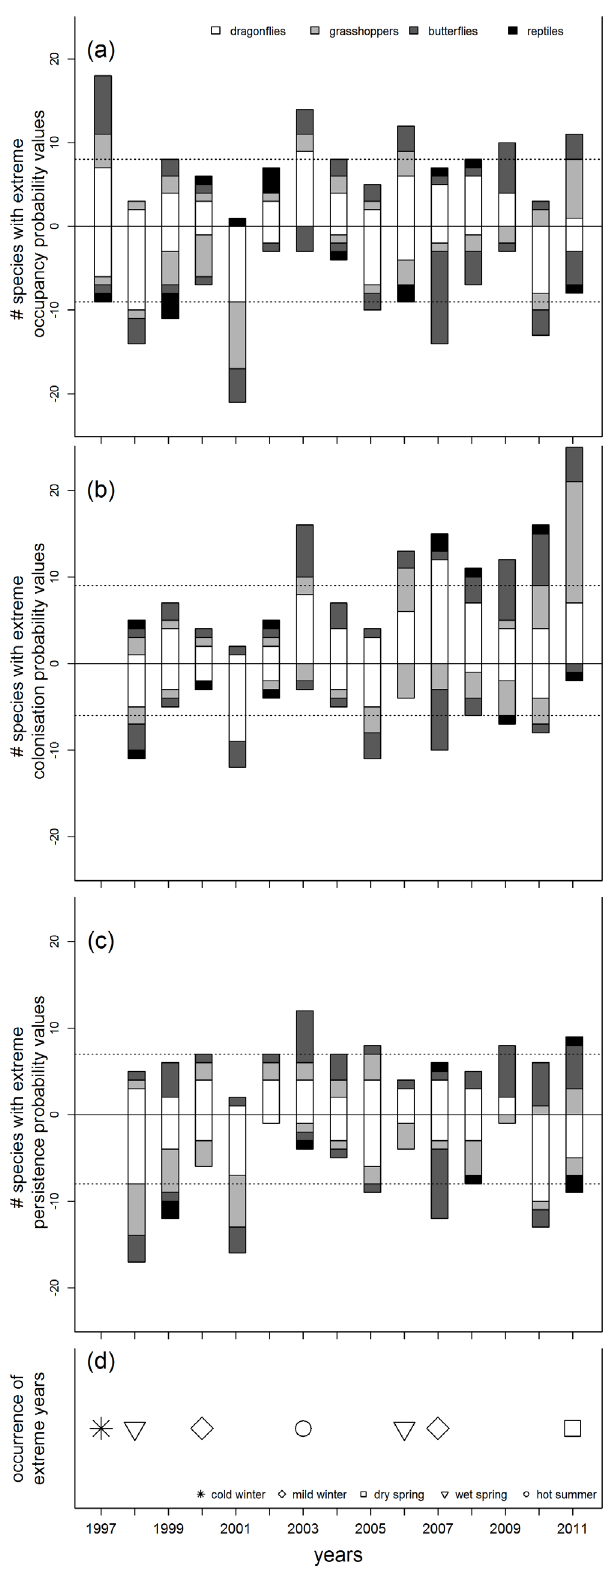
Figure 3. Number of species per year that show extreme values of metapopulation metrics (de-trended). Positive frequencies refer to years with values greater than mean value + 1.5 times standard deviation, negative frequencies refer to years with values smaller